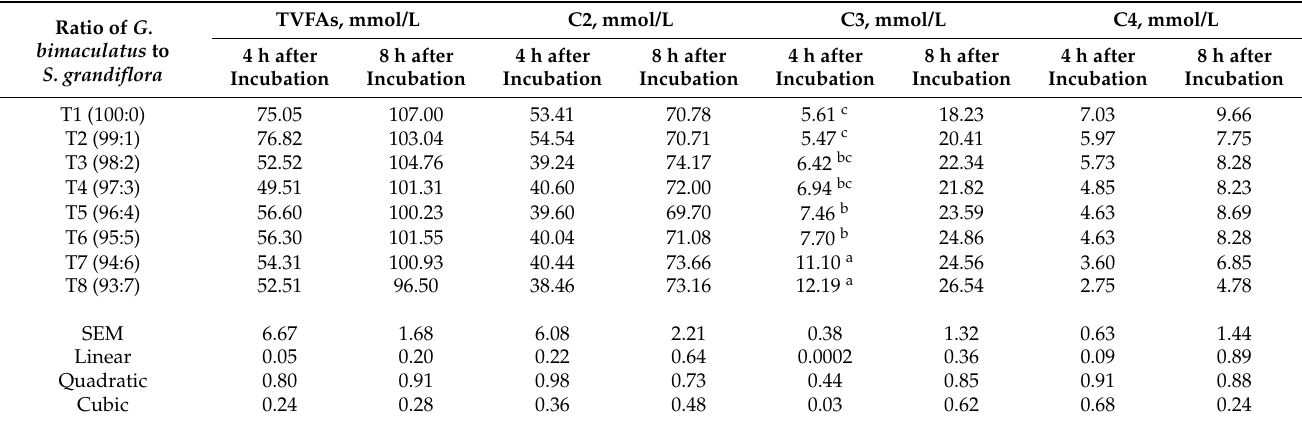
Table 6. Effect of manipulation of in vitro protein degradation from G. bimaculatus powder combined with phytonutrients from S. grandiflora on total volatile fatty acids, acetic acid, propionic acid, and butyric